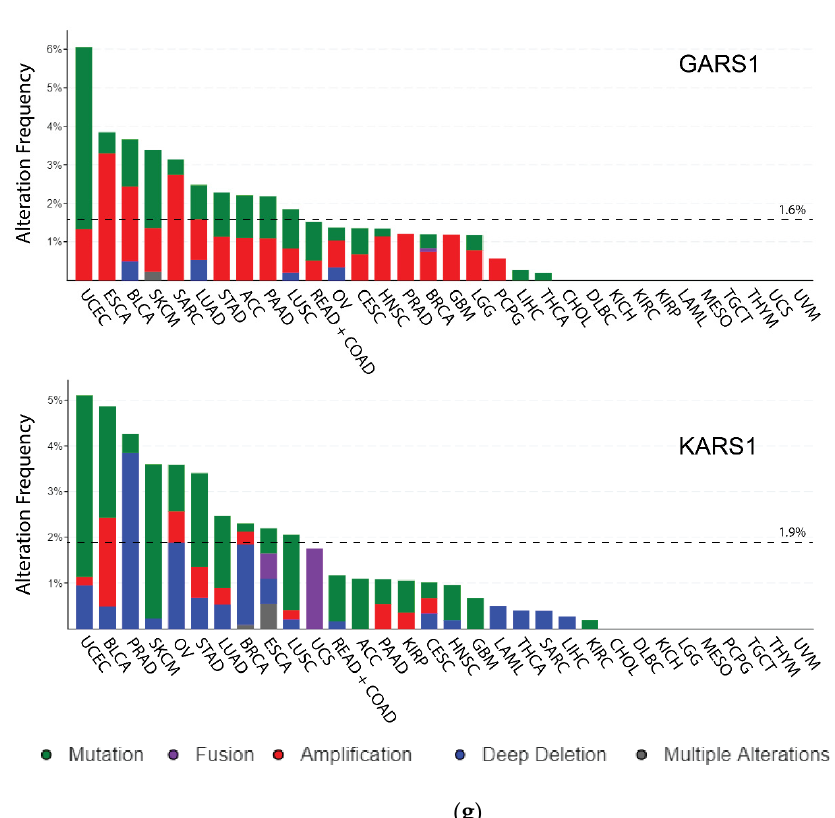
Figure 1. Copy number variation (CNV) and mutation frequency among the aminoacyl-tRNA synthetases (aaRSs) and representative proteins from TCGA. The CNV and mutational profiles of RB1 (representative tumor suppressor), MYC (representative proto-oncogene), and EIF4E (representative translation factor) are shown in ( a ). The same analysis is performed for the aggregated cytoplasmic and mitochondrial aaRSs in ( b ). To highlight the how cytoplasmic and mitochondrial synthetase profiles can either align or differ, the profiles for ( c ) HARS1 / HARS2 , ( d ) TARS1 / TARS2 , ( e ) SARS1 / SARS2 , and ( f ) NARS1 / NARS2 are displayed side-by-side. GARS1 / KARS1 are represented in ( g ) as the two synthetases which are dual localized to the cytoplasm and mitochondria. The dashed line represents the proportion of all cancer patients with any of the genomic alterations described in the figure.